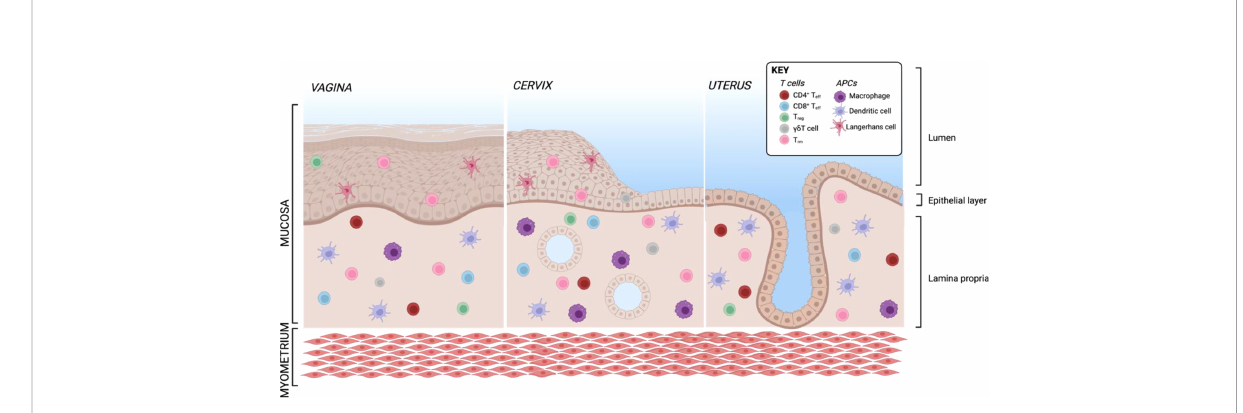
FIGURE 5 Resident T cells and APCs in the human FRT. Created with